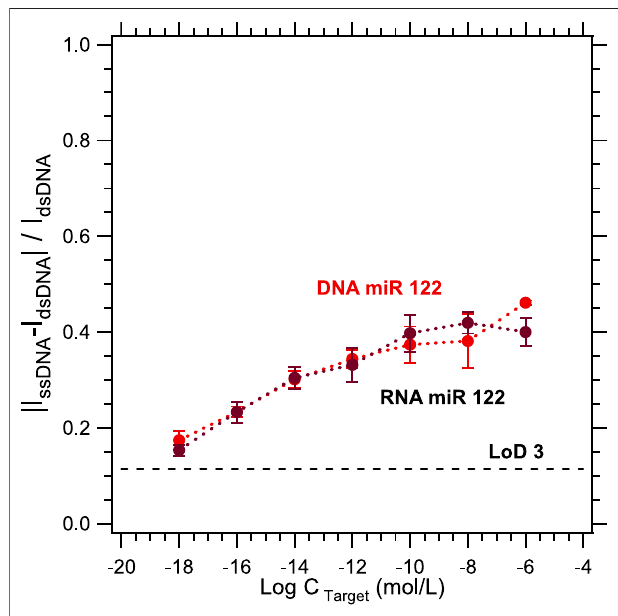
FIGURE 6 | Calibration curves for the hybridization detection comparison between DNA/DNA duplex (red dots) and DNA/RNA duplex (black